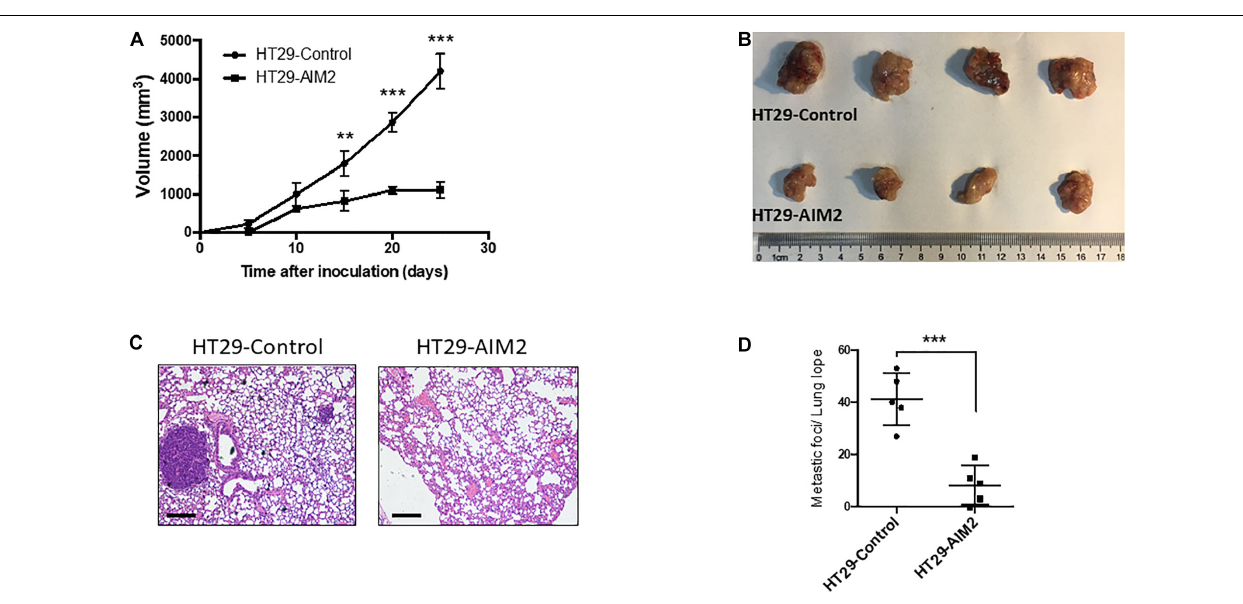
FIGURE 5 | Restoration of AIM2 expression inhibits BRAF-mutant CRC tumor growth and metastasis in vivo . (A) Tumor growth curves of AIM2 overexpressed HT29 cells and control cells in nude mice ( n = 4, Student’s t -test). (B) The picture of tumors isolated from nude mice 25 days after tumor cell injection ( n = 4). (C) Lung metastasis was determined by hematoxylin-eosin staining ( n = 5). Scale bar: 100 µ m. (D) The number of lung metastasis foci in nude mice injected with overexpressed AIM2 HT29 cells and control cells ( n = 5, Student’s t -test). * p < 0.05, ** p < 0.01, *** p <